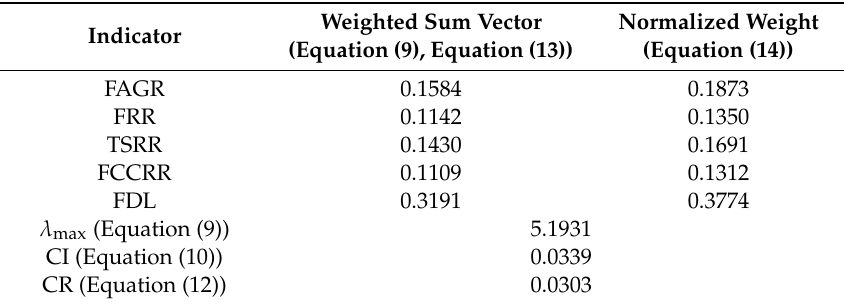
Table 4. Weight of each indicator.